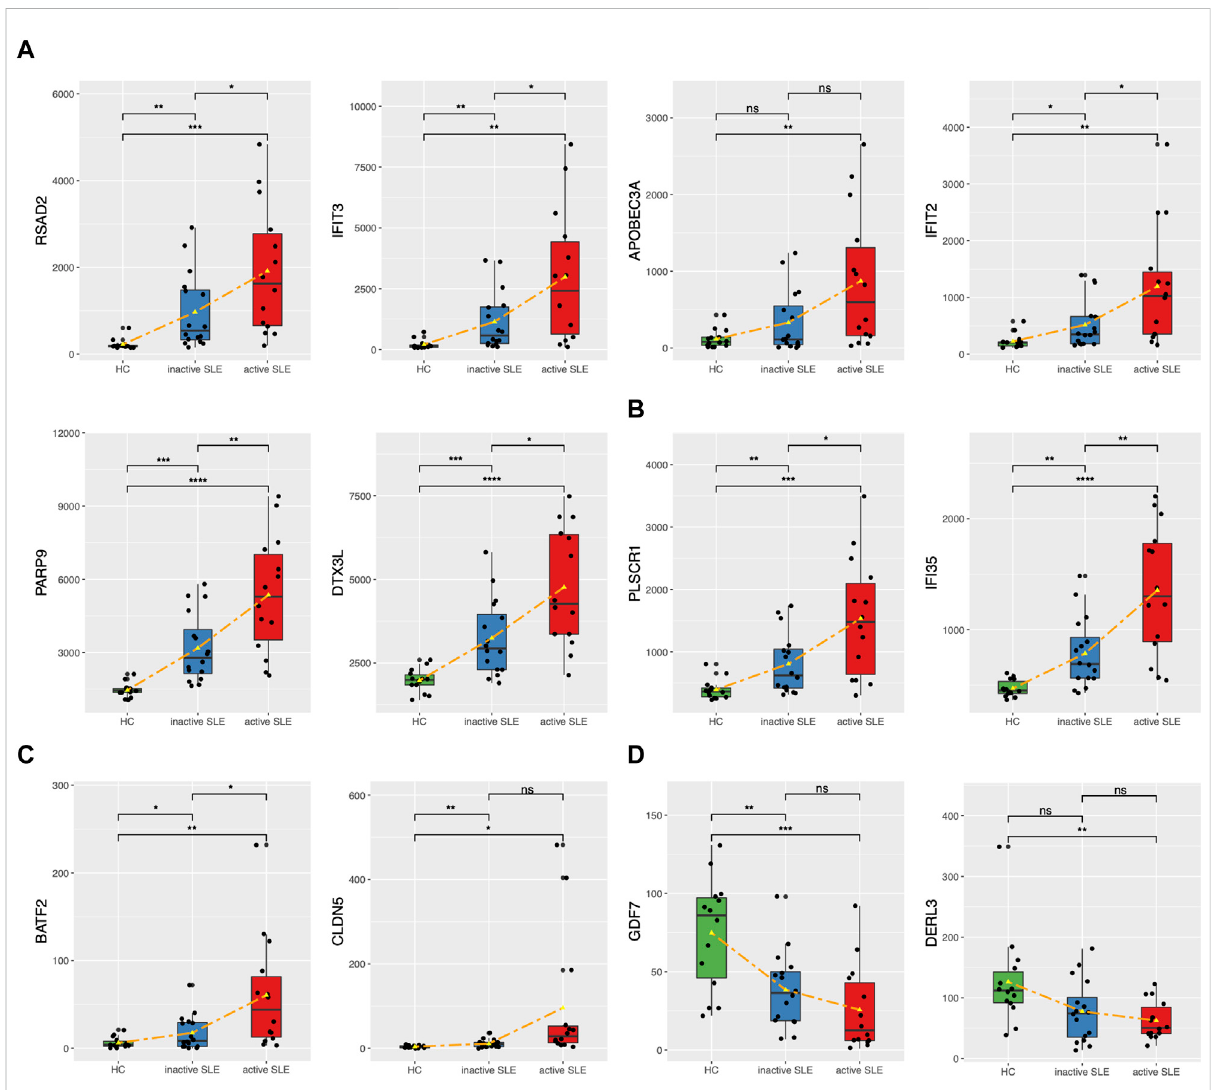
FIGURE 6 The expression levels of potential key genes in HC and SLE patients. (A,B) The expression levels of candidate ISGs in CD4 + T cells from HC, inactive and active SLE patients. (C,D) The expression levels of upregulated BATF2 and CLDN5 (C) and downregulated GDF7 and DERL3 (D) in CD4